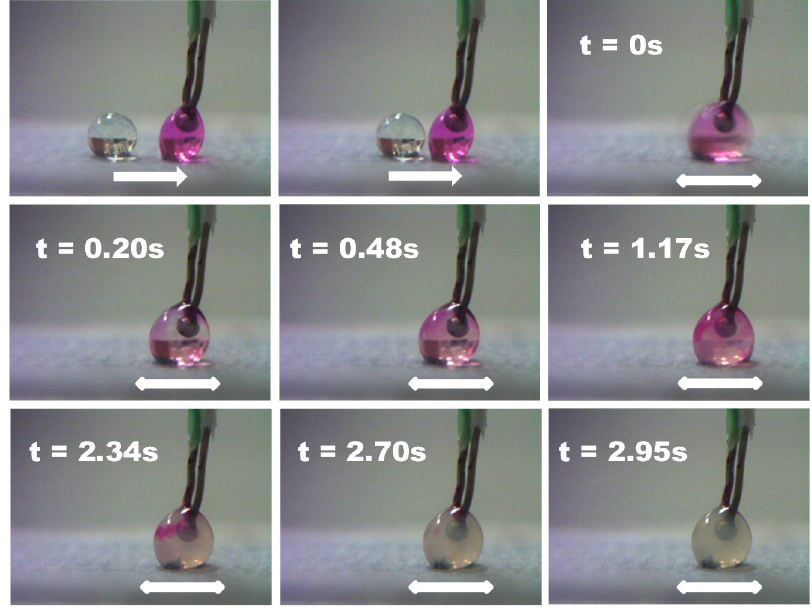
Figure 3. The sequence of frames to illustrate the merging and mixing of the HCl and NaOH